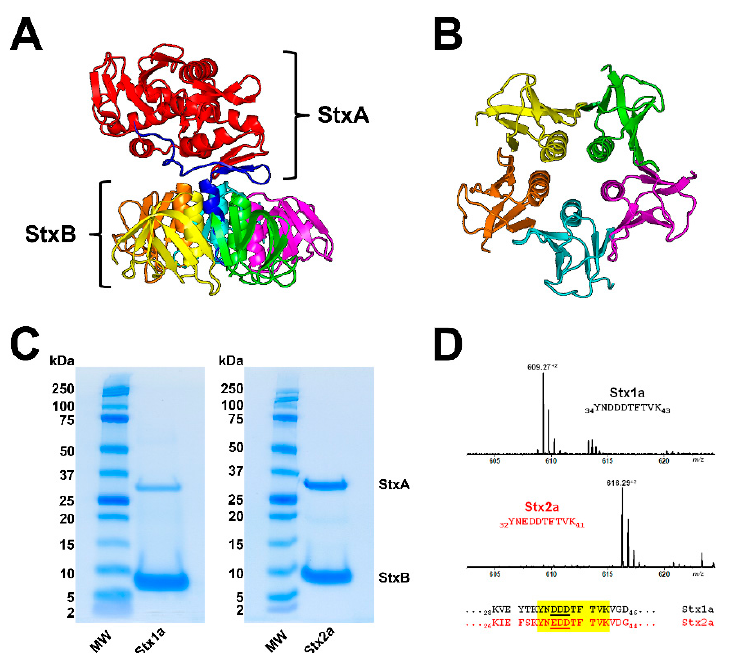
Figure 1. Ribbon diagrams of the Stx2a crystal structure ( A ) and the homopentameric StxB viewed from below ( B ); SDS-PAGE-separated affinity-purified Stx1a and Stx2a ( C ) and signals of Stx1a and Stx2a subtype-specific diagnostic peptide ions detected by mass spectrometry ( D ). The structure of Stx2a (1R4Q) was drawn with PyMOL Molecular Graphics System, Version 2.0 (Schrödinger, Synaptic Science, LLC, Bethesda, MD, USA) based on the amino acid sequence published by Fraser and co-workers [171] deposited in the Research Collaboratory for Structural Bioinformatics (RCBS) data bank (https://www.rcsb.org/structure/1R4Q, 5 June 2022). The StxA subunits (StxA) and StxB subunits (StxB) were separated under reducing conditions and stained with Coomassie Blue ( C ). Diagnostic peptide ions derived from tryptic digestions of the B subunits of Stx1a and Stx2a, the peptide positions and their amino acid sequences within the B subunits are highlighted in yellow (taken from Steil and co-workers [170]. 3.2. Glycosphingolipid Receptor Lipoforms GSLs are amphipathic molecules that are composed of a hydrophilic glycan moiety and a hydrophobic twin-tailed ceramide (Cer), which is built up from a long-chain amino alcohol and a fatty acyl chain [172–178]. While sphingosine (d18:1; sphingenine) represents the most common base as a constant part of GSLs’ ceramide, the fatty acyl chain can vary in chain length from C14 to C26 leading to various GSL lipoforms. It was the German physician Johann Ludwig Wilhelm Thudichum, who coined the term “sphingosine” in 1884 for its enigmatic “Sphinx-like” properties [172,179]. In Greek mythology, the sphinx is a monster that posed a riddle to all it encountered and destroyed those who could not answer the riddle [179]. Today, (glyco)sphingolipids are the subjects of intense studies aimed at elucidating their role in the cell membrane, their participation in signaling and recognition events, and especially their involvement in pathological processes being the basis for numerous human diseases [172,174–178]. Hemorrhagic colitis and life-threatening HUS caused by EHEC is triggered by Stx, the HUS-associated key virulence factor of this pathogen. The Stx subtypes Stx1a and/or Stx2a released by EHEC are of central importance in the development of the disease recognizing globo-series GSLs on the long known target cells videlicet endothelial cells of kidney and brain [165,166,180]. Stx1a and Stx2a bind with high priority to globotriaosylceramide (Gb3Cer, Gal α 4Gal β 4Glc β 1Cer), to much lesser extent to globotetraosylceramide (Gb4Cer, GalNAc β 3Gal α 4Gal β 4Glc β 1Cer), and not at all to Gb5Cer (Gal β 3GalNAc β 3Gal α 4Gal β 4Glc β 1Cer) as exemplarily shown in Figure 2 for the